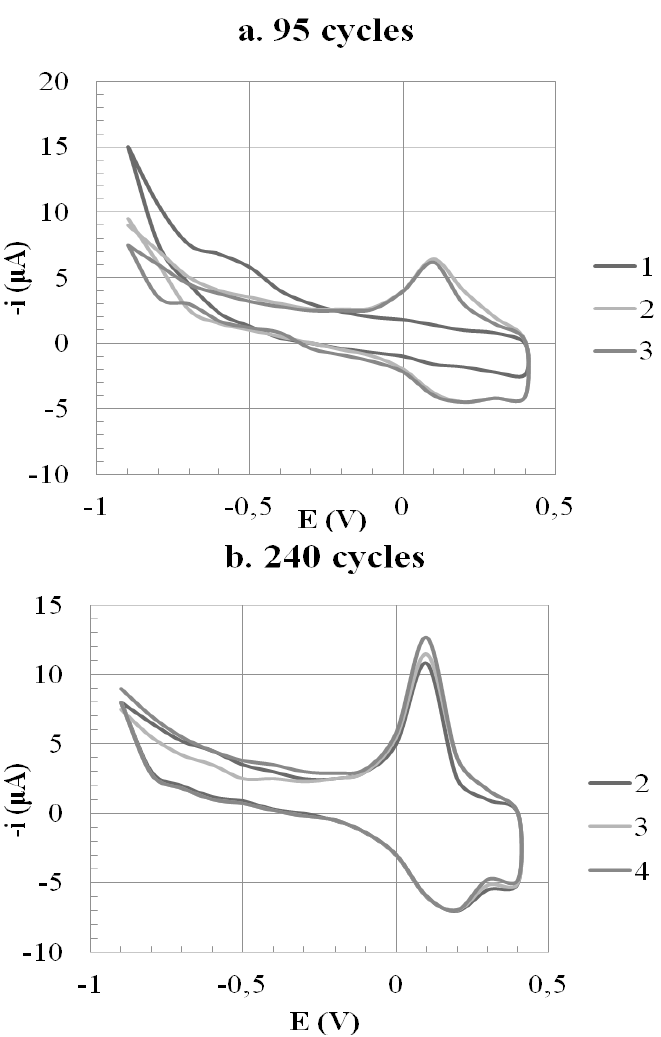
Figure 7. Cyclic voltammograms of (1) 1×10 -3 mol L -1 Ni 2+ +1 mol L -1 H (3) 1×10 -3 Ni 2+ mol L -1 +1 mol L -1 H (Scan rate = 50 mV s -1 ), (a) PoAP obtained film after 95th polymerization cycle of 1×10 -3 mol L -1 oAP in 1 mol L -1 HClO 100 mV s -1 ), (b) PoAP obtained film after 240th polymerization cycle of 1×10 -3 mol L -1 oAP in 1 mol L -1 HClO